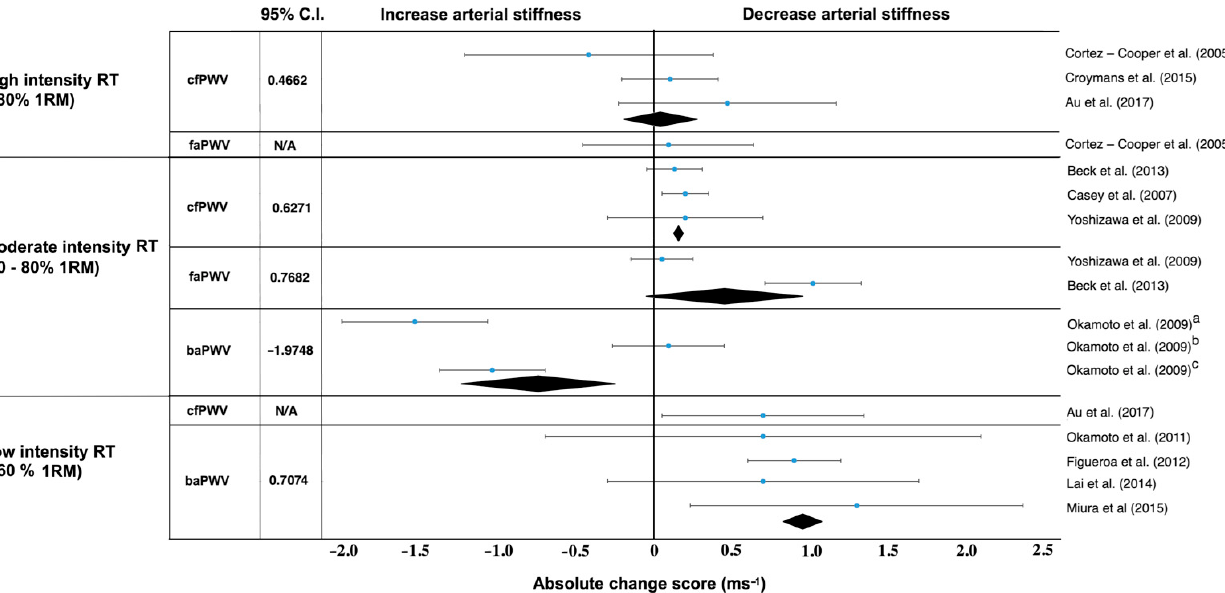
Figure 3. Absolute change score (ms − 1 ) in long-term resistance training programs. a upper limb training group, b lower limb training group, c group of resistance training with slow lifting and quick lowering. baPWV, brachial–ankle pulse wave velocity; caPWV, carotid–femoral pulse wave velocity; faPWV, femoral–ankle pulse wave velocity; RM, repetition maximum. Black diamonds represent the weighted mean and standard error, blue dot is the mean difference with standard deviation.